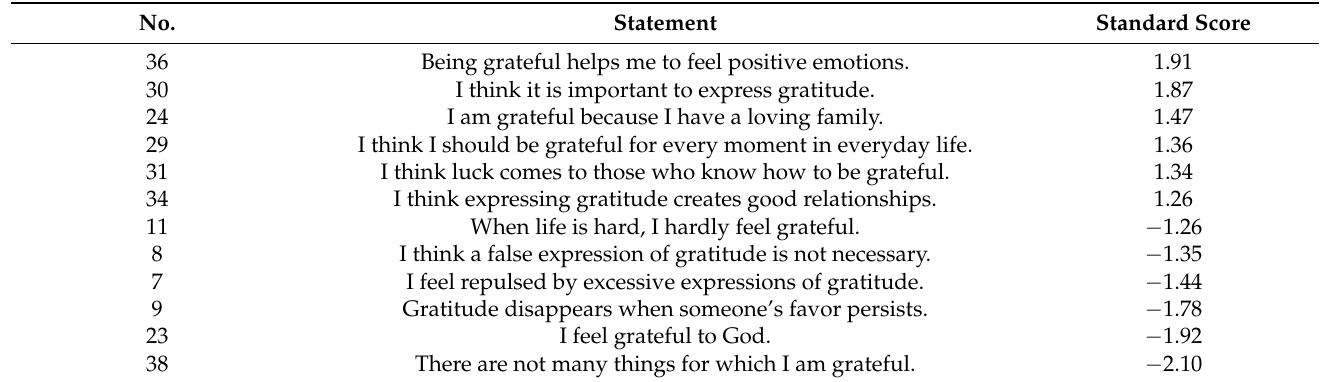
Table 7. Statements and standard scores (at least ± 1.00) of Type